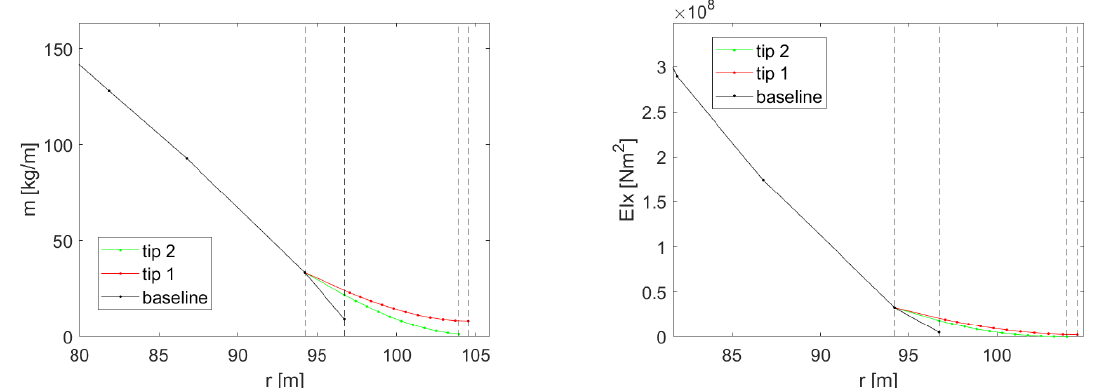
Figure 3. Mass and flapwise stiffness for two reference tips at the borders of the design space. Vertical dashed lines indicate the location of the control points.